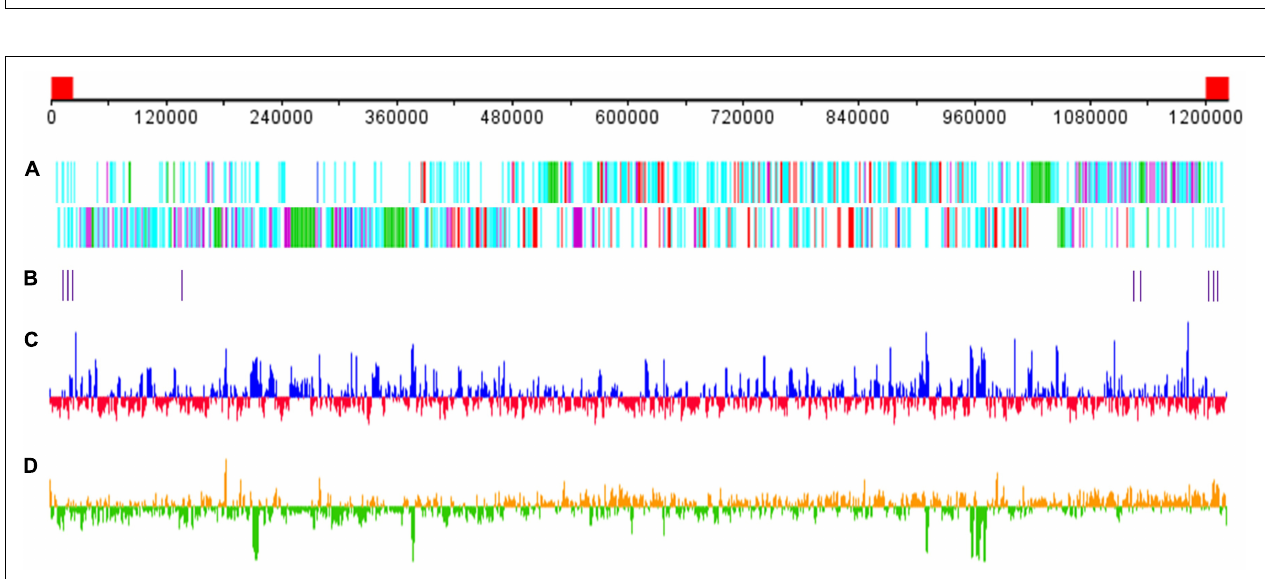
FIGURE 2 | Schematic representation of the Me. baoshan genome. (A) Distribution of ORFs. Upper line and lower line represented plus and negative strand, respectively. Genes were color-coded according to the characteristics of their gene products. Green: FNIP repeat domain-containing proteins; purple: Ankyrin repeat domain-containing proteins; red: single copy proteins; blue: translation-related proteins; cyan: other proteins. (B) Distribution of tRNA genes. (C) GC content with higher or lower GC% compared with whole genome average in blue or red, respectively. (D) GC skew for 1000-bp window and 500-bp step with skew+ in orange and skew– in green. The red block in the genome scale line (top) represent the ITRs.